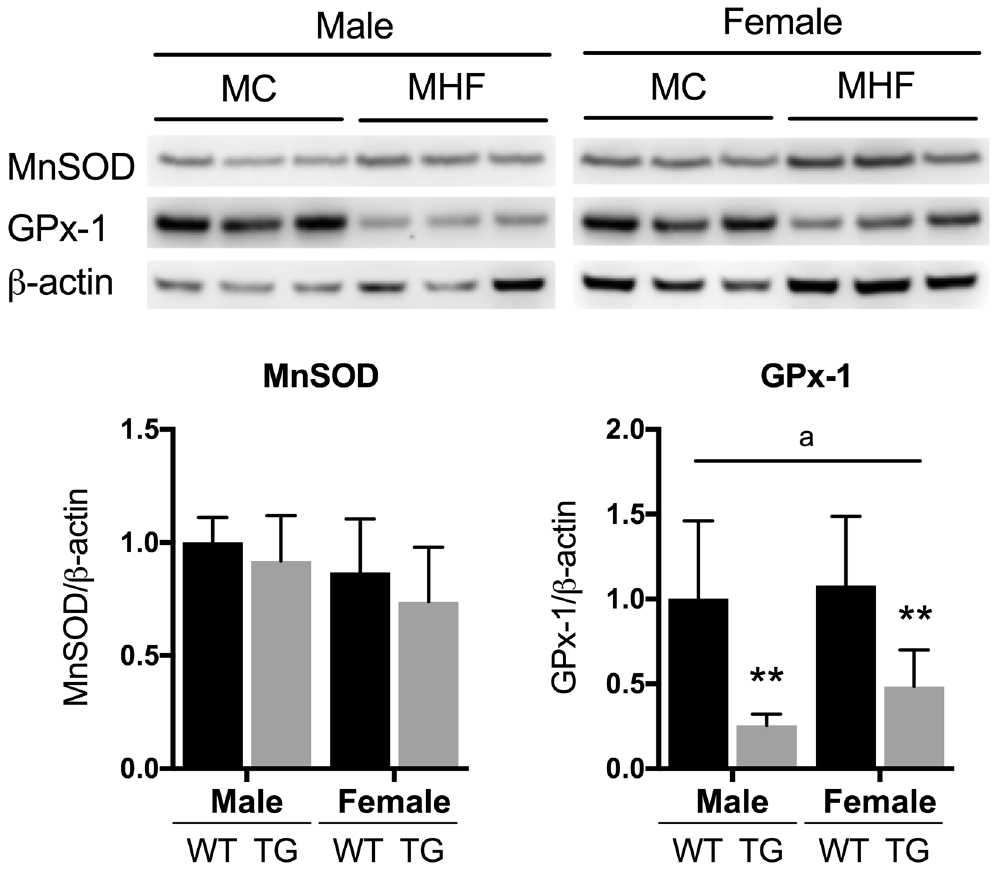
Figure 5. Regulation of renal antioxidant markers in male and female offspring. MC (offspring of dams fed chow); MHF (offspring of dams fed high-fat diet). MnSOD (Manganese superoxide dismutase); GPx1 (Glutathione Peroxidase 1). Results are expressed as mean ± SD. Data were analysed by two-way ANOVA followed by Bonferroni post hoc test. a (P < 0.05, Maternal diet effect), ** P < 0.01 (vs MC offspring). n = 6.